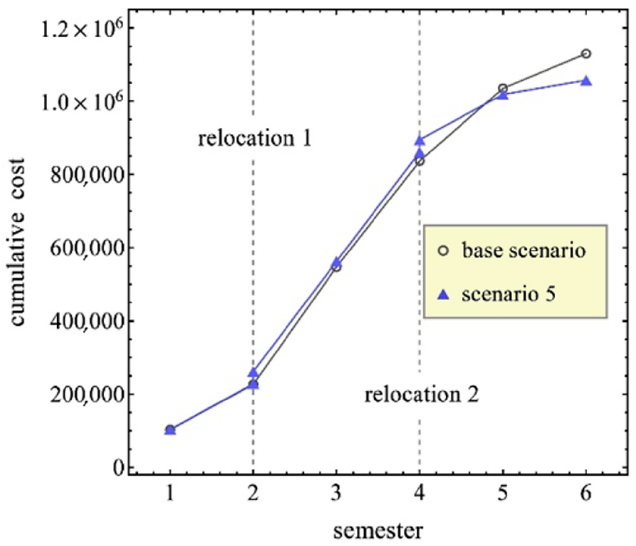
Figure 5. Comparison of cumulative costs.